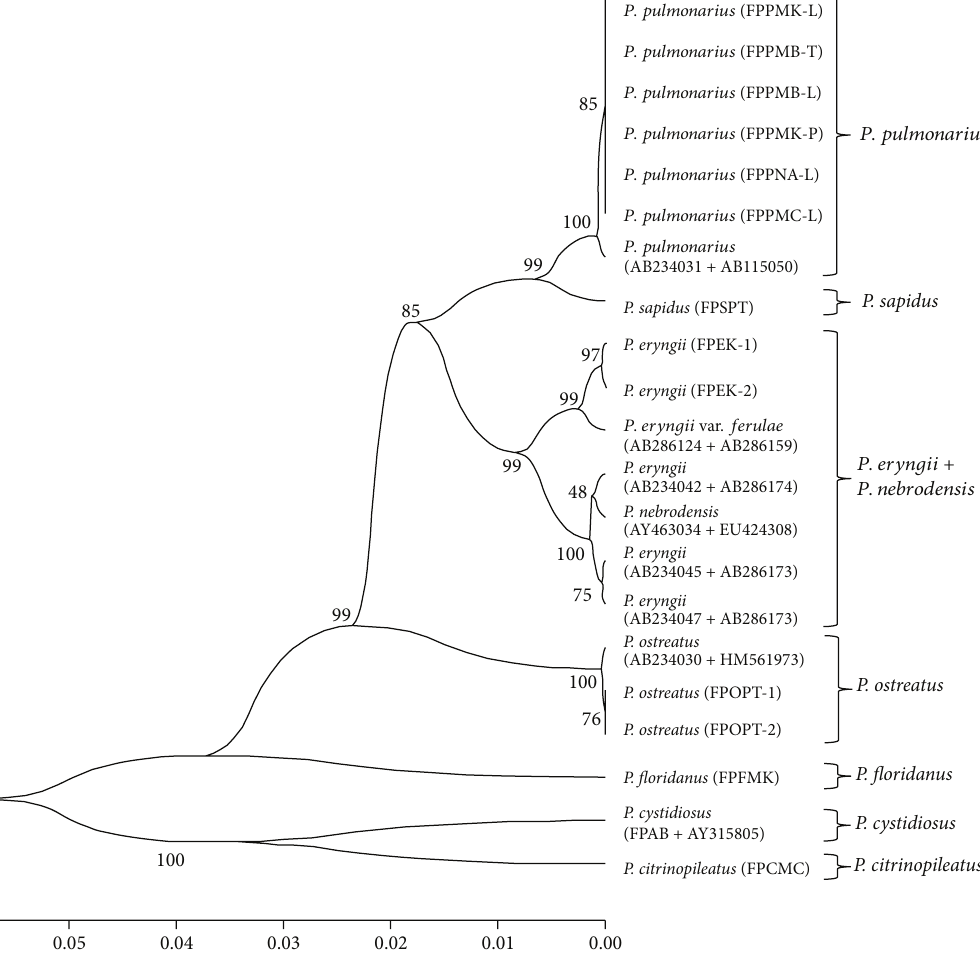
Figure 4: Phylogenetic tree constructed by the combination of IGS1 and ITS sequences using UPGMA method. The IGS1 sequences of AB234031 ( P. pulmonarius ); AB234030 ( P. ostreatus ); AB234045, AB234042, and AB234047 ( P. eryngii ); AY463034 ( P. nebrodensis ); and AB286124 ( P. eryngii var. ferulae ) as well as ITS sequences of HM561973 ( P. ostreatus ); AB115050 ( P. pulmonarius ); AB286159 ( P. eryngii var. ferulae ); AB286173 and AB286174 ( P. eryngii ); EU424308 ( P. nebrodensis ); and AY315805 ( P. cystidiosus ) were downloaded from NCBI GenBank. Numbers close to branches indicate 1000 replications of bootstrap test and codes represent the sample